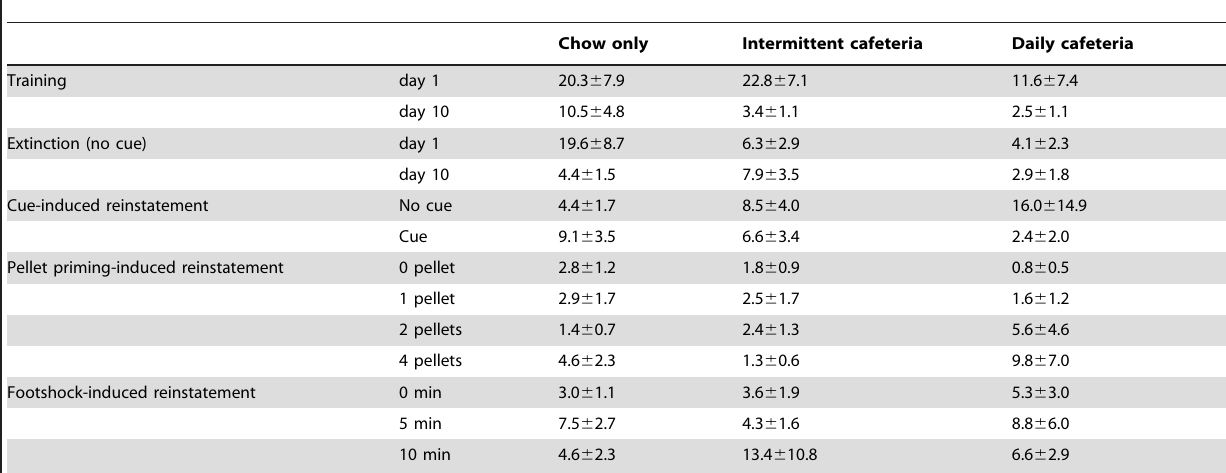
Table 1. Summary of inactive-lever presses during the training, extinction, and reinstatement testing.